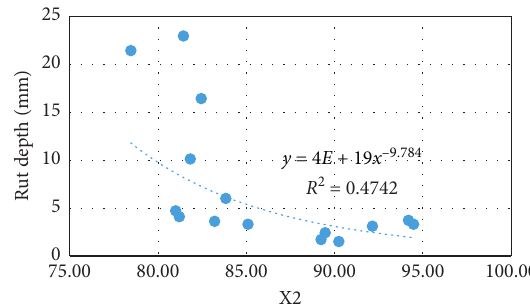
Figure 5: Correlation between X2 and rut depth ( n � 15).